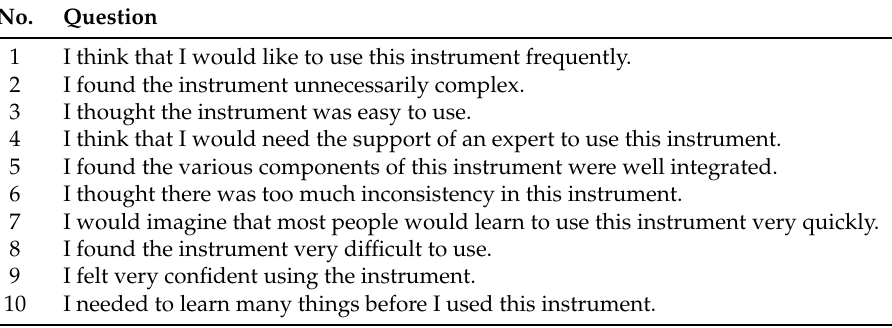
Table 5. System Usability Scale (SUS) to evaluate the usability of the instrument.